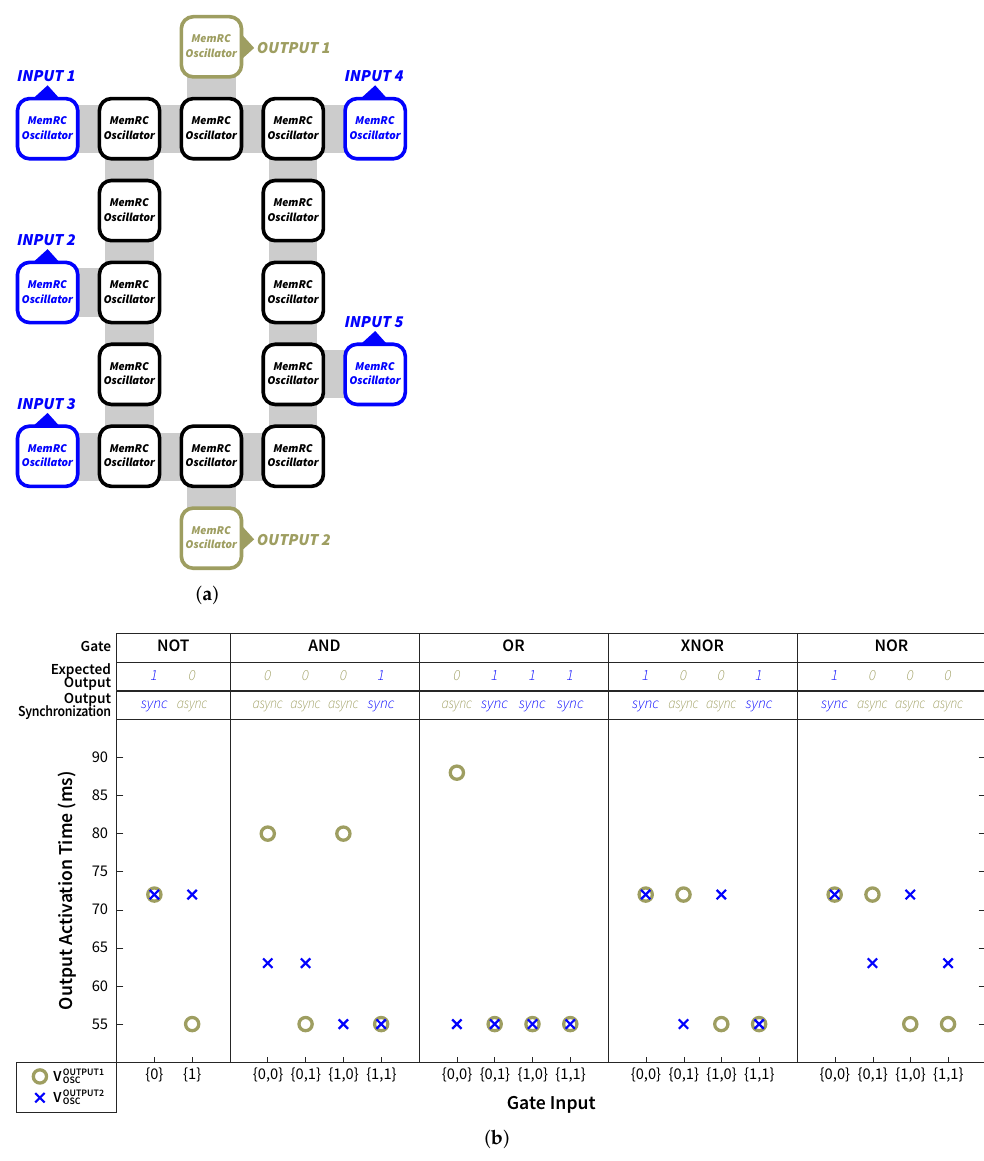
Figure 22. ( a ) Schematic of the multifunctional gate. ( b ) Activation time of the output channels for each possible logic operation and input